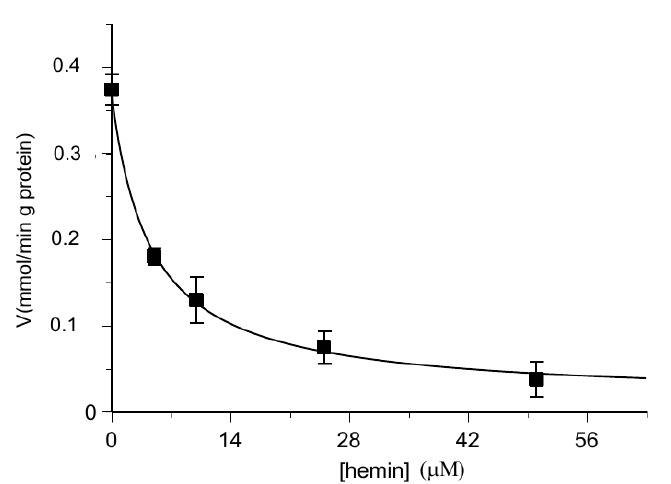
Figure 6. Inhibition of the transport activity of the [ 14 C] 2-oxoglutarate in the OGC carrier by hemin preloaded within proteoliposomes. The transport rate of [ 14 C] 2-oxoglutarate in proteoliposomes containing 6 mM of 2-oxoglutarate and increasing concentrations of hemin (0–50 μM) was measured in 2 min. Additionally, [ 14 C] 2-oxoglutarate was added at a concentration of 0.025 mM. The values are the means ± SD from three independent experiments.